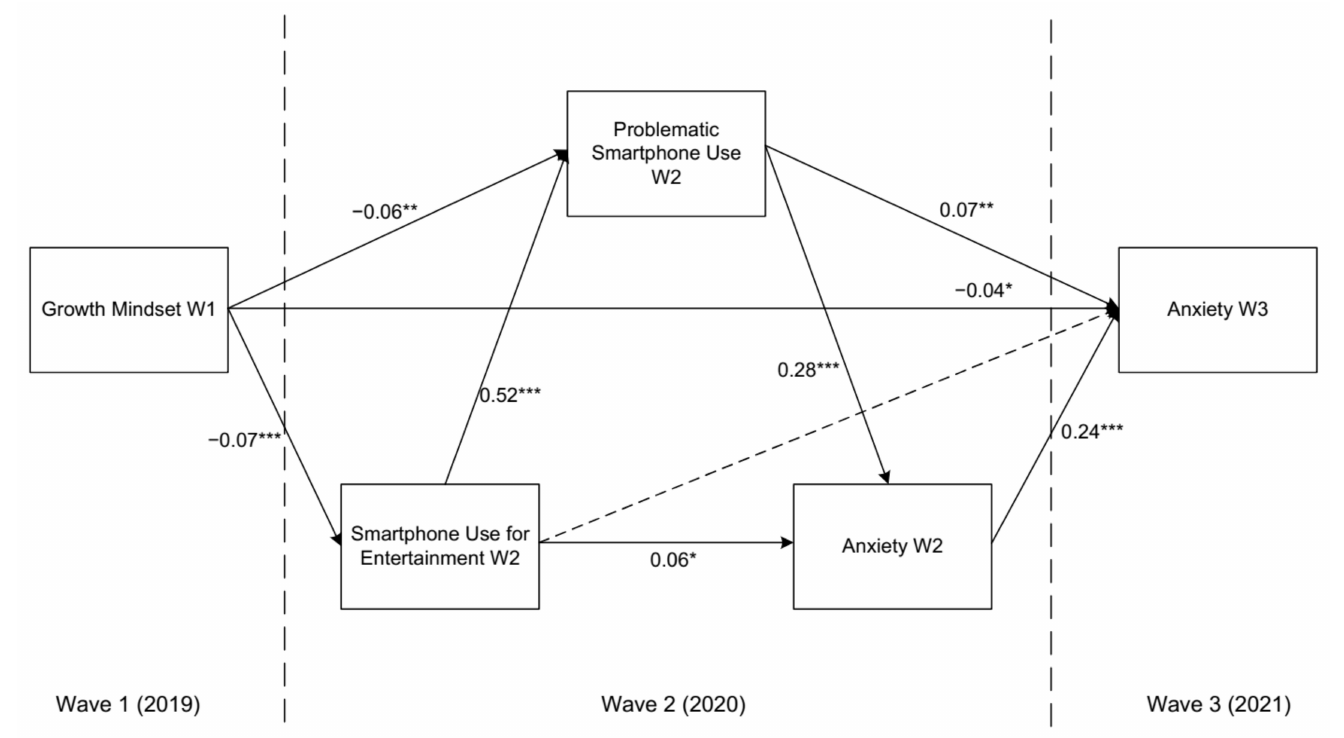
Figure 1. The longitudinal multiple mediation model of the effect of the growth mindset on adolescent anxiety. Statistics are standardized path coefficients. Dotted lines represent a nonsignificant relation. The model also includes sex, age, and SES as covariates in Waves 2 and 3, which are not shown for